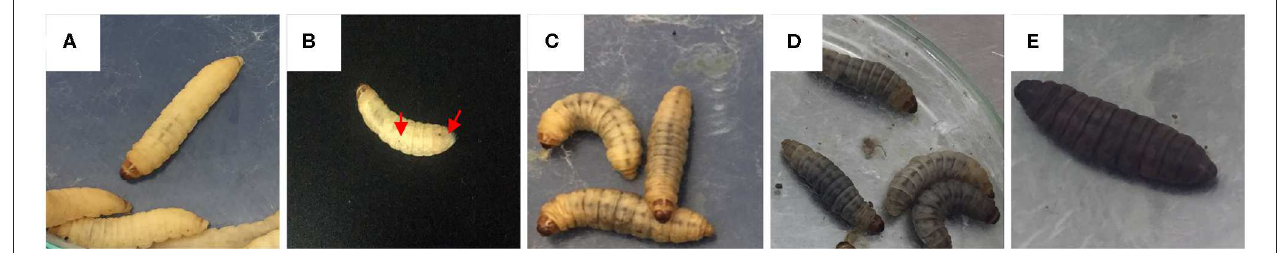
FIGURE 1 | Melanization scores based on the health index scoring system. (A) melanization score 4, no melanization; (B) melanization score 3, < 3 spots on beige larva (black arrows showing the spots); (C) melanization score 2, more than three spots on beige larva; (D) melanization score 1, black spots on brown larva; and (E) melanization score 0, full